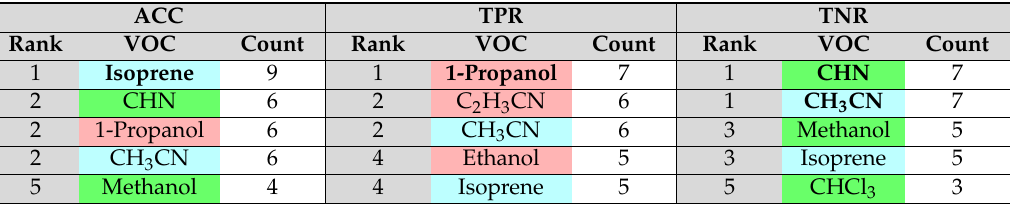
Table 5. VOCs that are frequently used in the top 10 ACC (Table 2), TPR (Table 3), and TNR (Table 4) combinations. The VOCs written in boldface are the same as those in Tables 2–4 and represent the VOCs that are used most frequently in the ACC-, TPR-, or TNR-based diagnoses. VOCs commonly used in every diagnosis and those specifically used for TPR- and TNR-based diagnoses are colored by blue, red, and green, respectively.